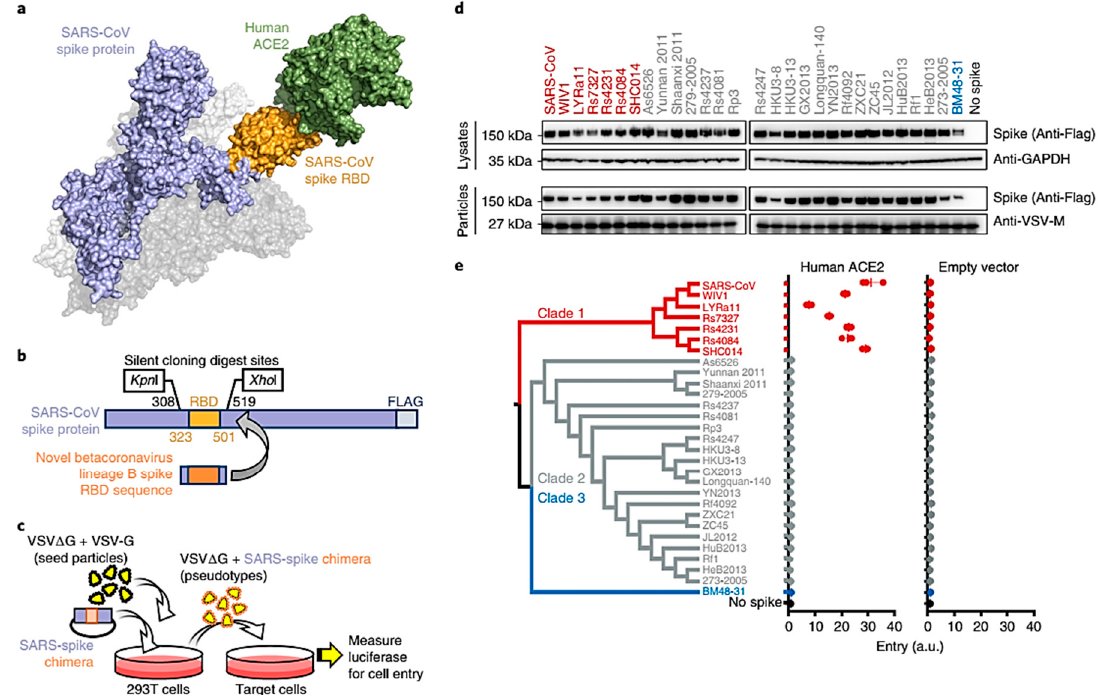
Figure 4. β -CoVs lineage B entry with angiotensin-converting enzyme 2 (ACE2) is clade specific: ( a ) β -CoVs, comprising SARS-CoV, interact with the host–cell receptor through the receptor-binding domain (RBD) in spike (Protein Data Bank ID: 5X5B; 2AJF), ( b ) Engineered silent mutations in SARS-spike eased replacement of the RBD sequence. SARS-spike amino acid numbers are designated in black towards the silent cloning sites or orange for the RBD, ( c ) The experimental workflow outline, ( d ) Western blot of creator cell lysates and concentrated reporter particles. The labels along the top illustrate the origin of the RBD in the SARS-CoV spike protein, ( e ) Cladogram of the 29 spikes tested. The data are representative of 3 technical replicates. Vertical bars indicate mean values of all three replicates and horizontal bars indicate s.d. Reproduced with permission from Ref. [28].